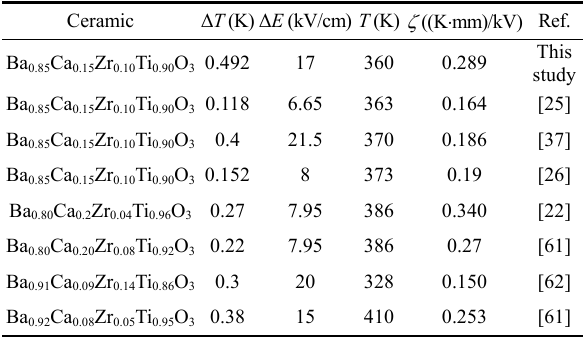
Table 3 Comparison of the electrocaloric properties of rod-like BCZT ceramics with other lead-free BCZT ceramics reported in literature